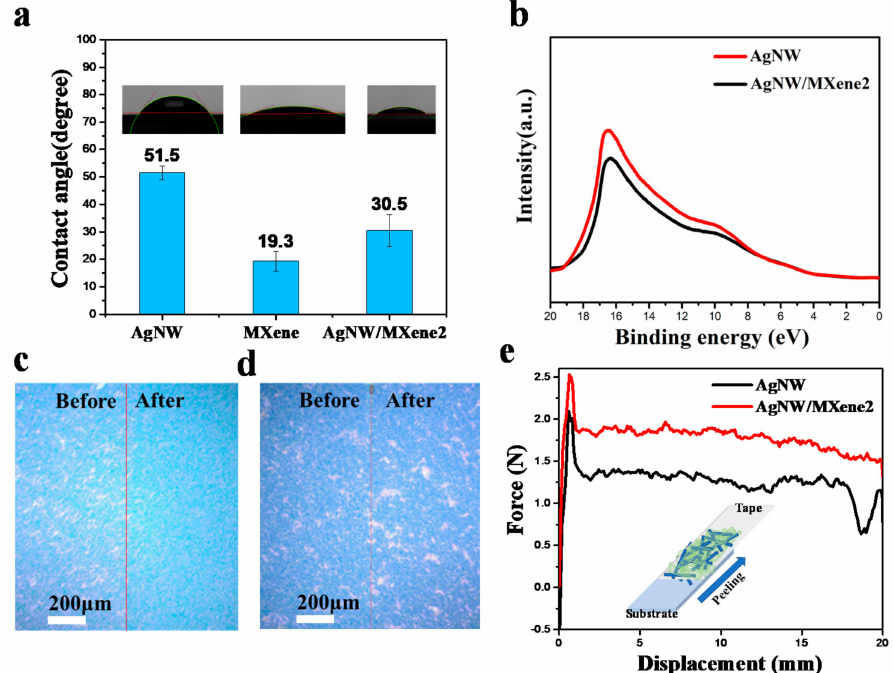
Figure 4. ( a ) The water contact angle values of various TCFs. ( b ) UPS spectra of AgNW and AgNW/MXene2 TCFs. ( c , d ) Optical images of AgNW and AgNW/MXene2 film after tapping tests. ( e ) Force–displacement curves for TCFs with and without MXene on PEN